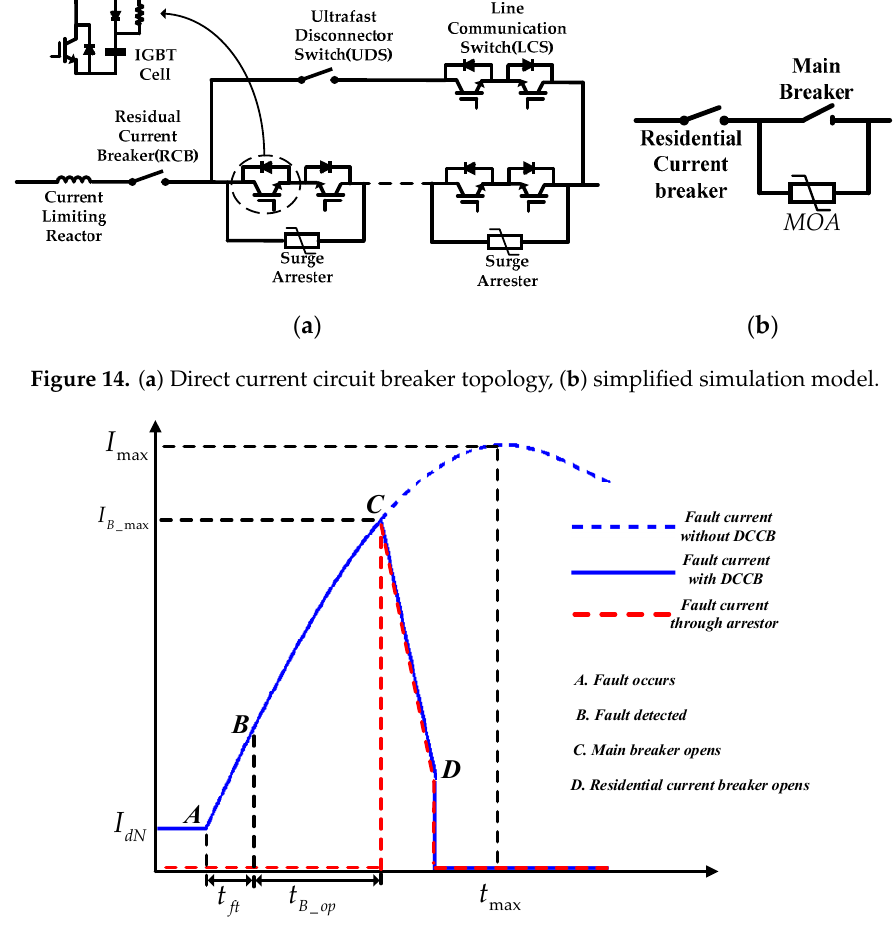
Appl. Sci. 2019 , 9 , x Figure 15. Fault current with hybrid DCCB operation. Figure 15. Fault current with hybrid DCCB operation. Figure 15. Fault current with hybrid DCCB operation.